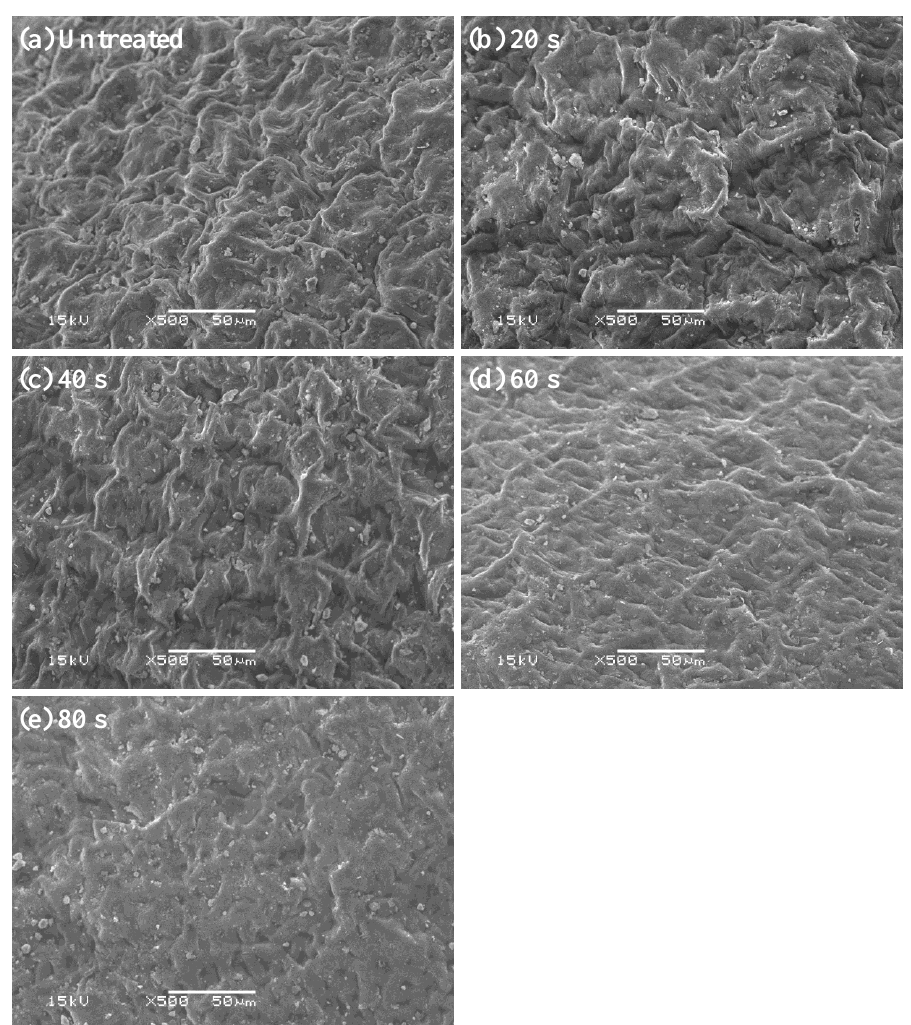
Figure 8. SEM image of broccoli seed ( a ) untreated, ( b – e ) plasma-treated for 20 s, 40 s, 60 s, and 80 s, respectively.